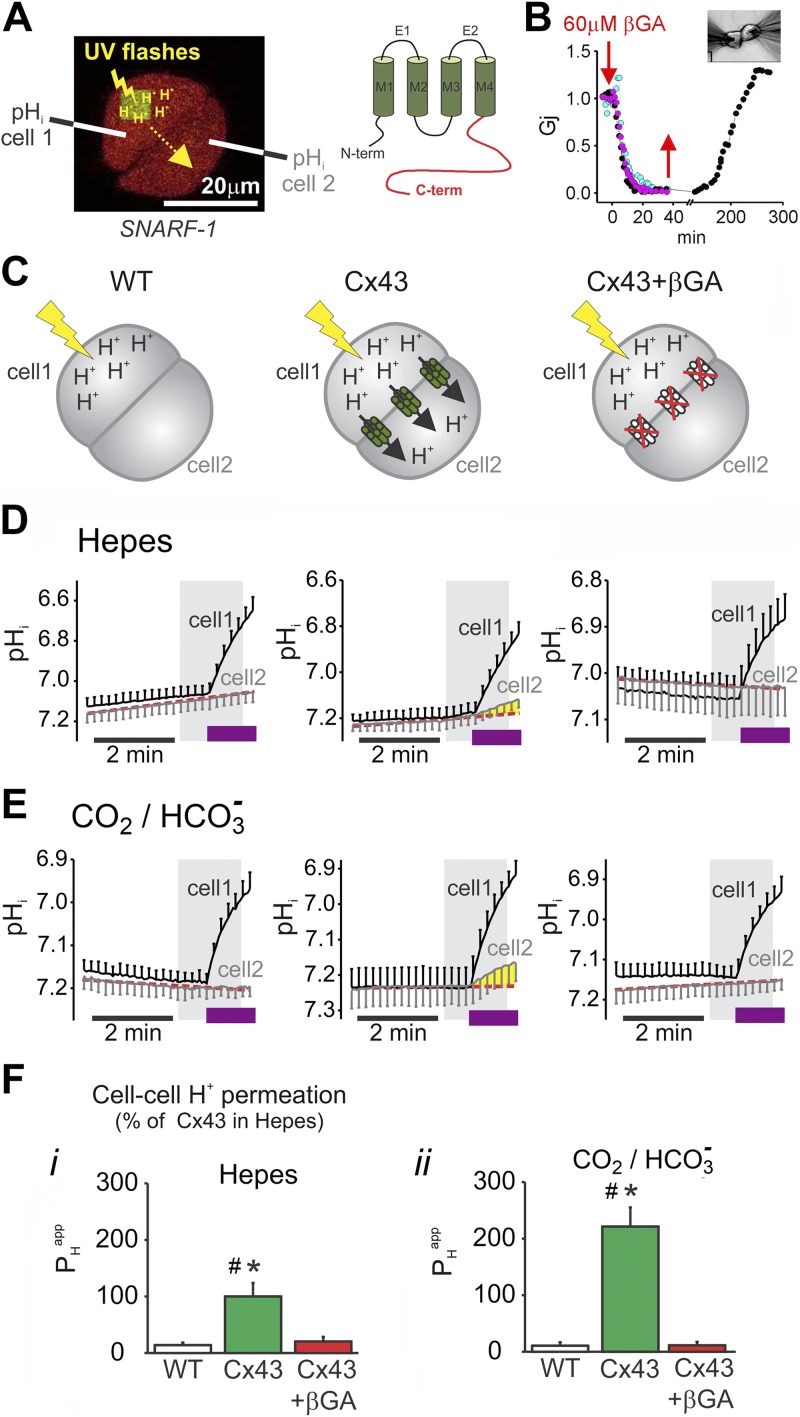
Cx43-mediated junctional H+ ion permeation. A) Photolytic H+ uncaging (triple flash of UV light/3.6 s) in 5 × 5-µm region of interest from 2-nitrobenzaldehyde (1 mM) in one cell of Cx43-transfected N2a cell pair produces a local acidification [confocally imaged 5-(and-6)-carboxy SNARF-1 fluorescence] that spreads to the distal cell via Cx43 channels, if active (left). Cartoon representation of wild-type Cx43 protein (right). B) N2a cells expressing wild-type Cx43 become uncoupled by 60 μM βGA (colored traces represent individual recordings). C) Schematic representation of the different coupling states from which permeability data are obtained (wild-type, Cx43 expressor, and Cx43 expressor inhibited with βGA). D) Cell-to-cell H+ ion permeation measured in Hepes-buffered superfusates in N2a cells (Cx43-negative). To highlight pHi changes in the recipient cell (cell-2), the dashed line extrapolates baseline. Substantial acidification of cell-2 is observed in Cx43 transfectants and is βGA sensitive. E) Cell-to-cell H+ ion permeation measured in CO2/HCO3− buffered superfusates. For panels D, E, the shaded regions correspond to the period we used to fit data using the mathematical models. Purple bands correspond to the uncaging period (flash photolysis). F) Summary of PHapp data. All H+ uncaging experiments were performed in the presence of 30 μM dimethylamiloride to inhibit acid extrusion by the NHE. Experiments in CO2/HCO3− buffer were also performed in the presence of 150 μm 4,4′-diisothiocyano-2,2′-stilbenedisulfonic acid. #Significantly different from 0 (P < 0.05). *P < 0.001.